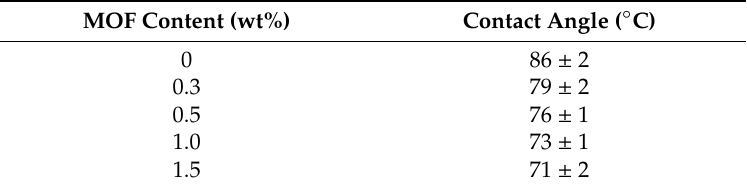
Table 4. Performance of membranes with di ff erent MIL-53 (Al) contents; Reproduced with permission from Ref